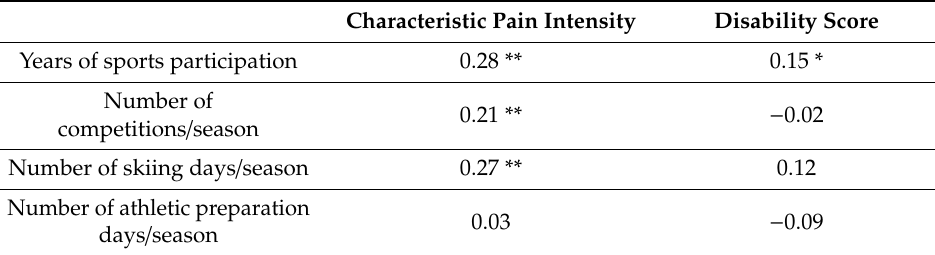
Table 3. Correlation between the Grading Chronic Pain Scale scores and questions on sports exposure. Characteristic Pain